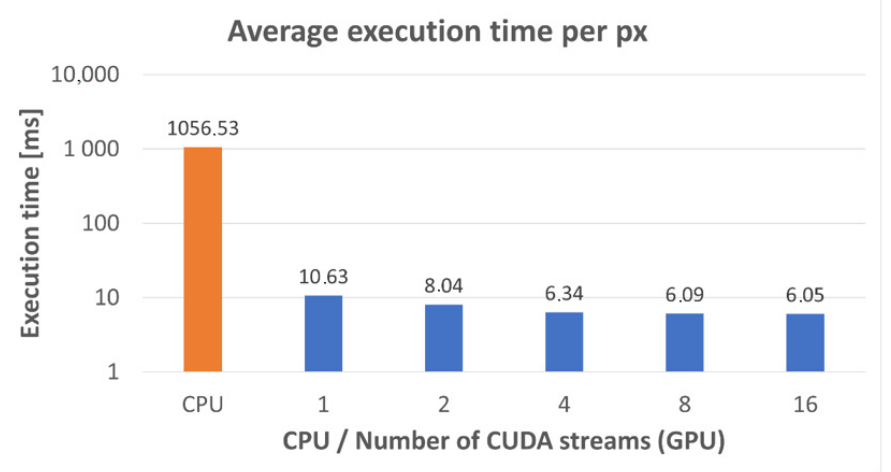
Figure 7. Average execution times of the SA procedure using CPU and GPU with different numbers of streams.